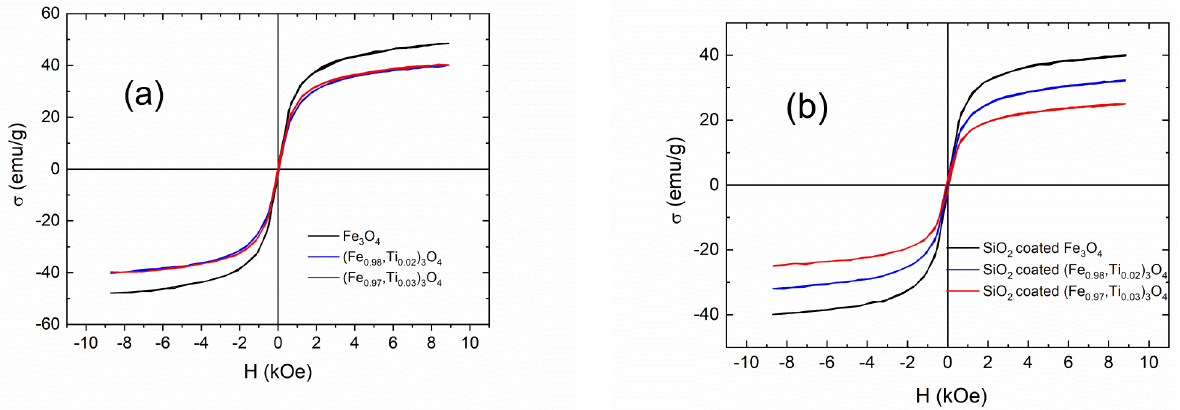
Figure 5. The magnetization measurements of ( a ) uncoated and ( b ) SiO 2 coated pure and Ti-doped magnetite.